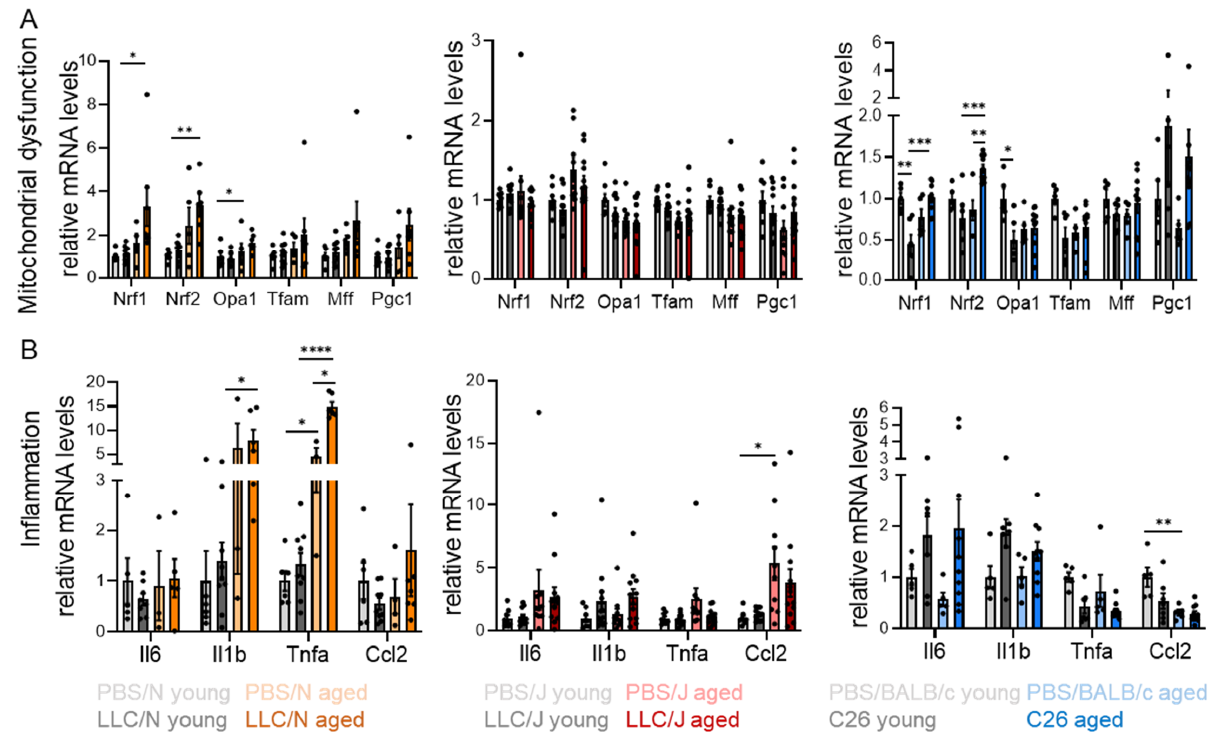
Figure 5. Age-dependent mitochondrial stress and inflammation in adipose tissue. ( A , B ) Expres- sion of genes involved in different inflammatory and stress-related pathways was analyzed in epididymal white adipose tissue (eWAT) of the same mice as in Figure 2. ( A ) Gene expression of individual markers of mitochondrial dysfunction. ( B ) Expression of inflammatory marker genes. Data are mean ± s.e.m. Statistical analyses were performed using two-way ANOVA with Tukey’s multiple-comparison post hoc test. * p < 0.05, ** p < 0.01, *** p < 0.001, **** p <